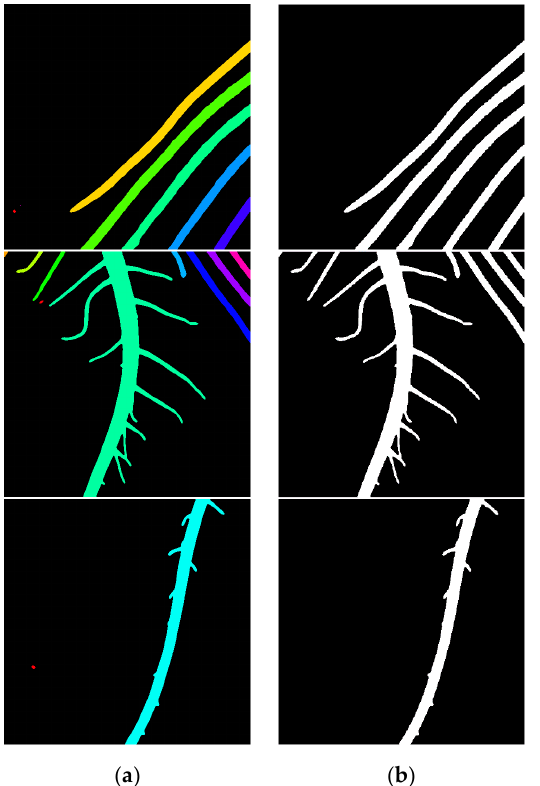
Figure 12. Connected component labeling and post-processing results. ( a ) Mark Connected component; ( b ) Image after stray noise removal.